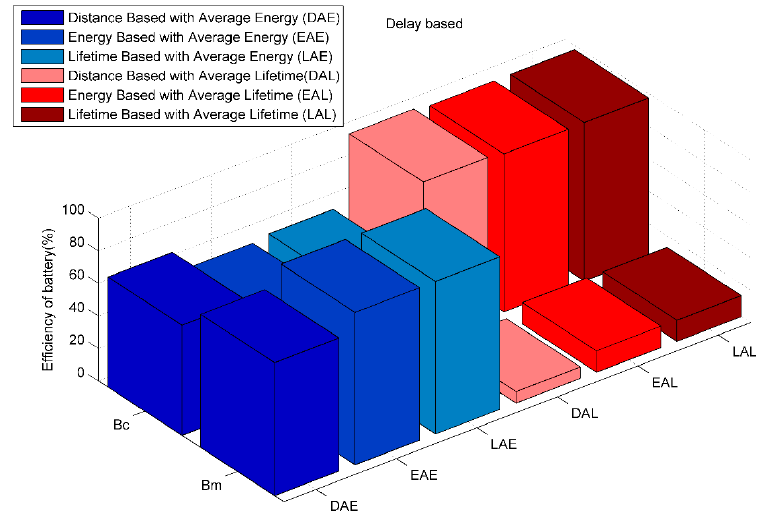
Figure 11. Efficiency of battery.